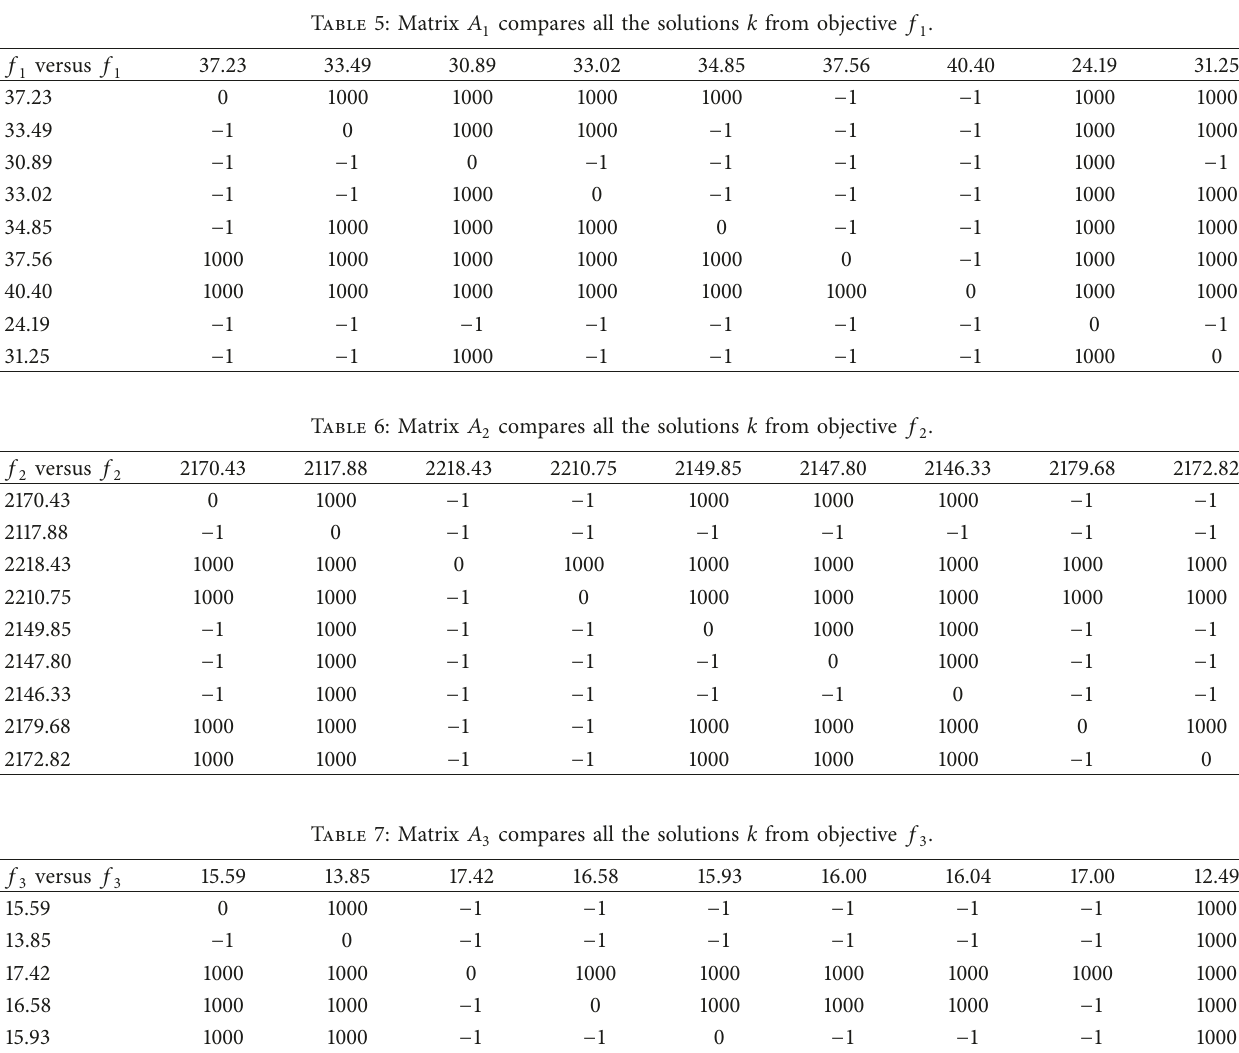
Table 5: Matrix A